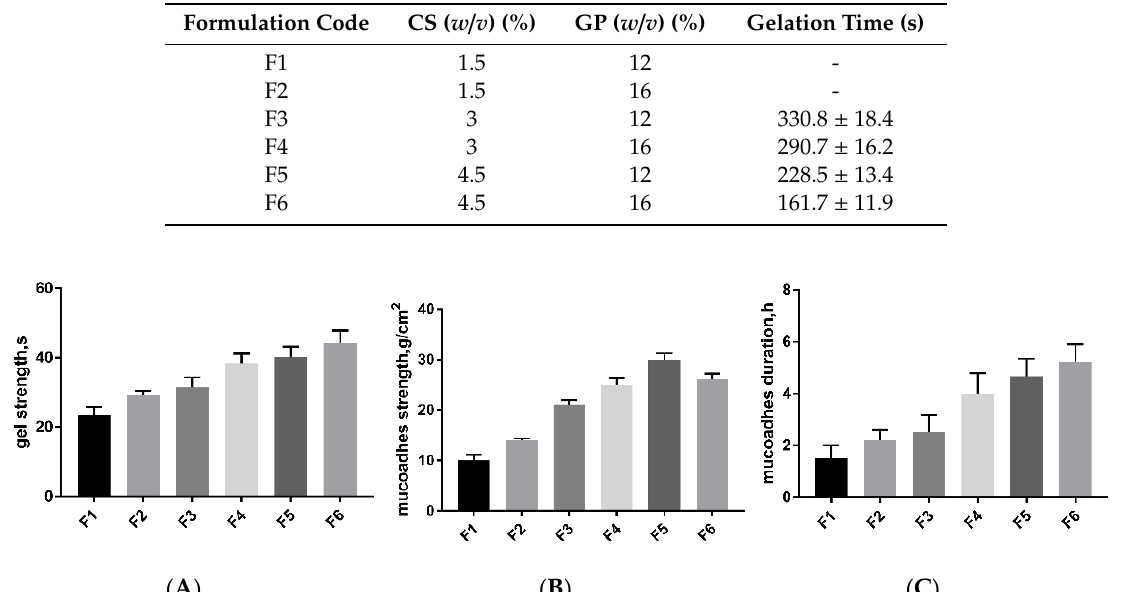
Figure 2. Gel properties. ( A ) Gelation gel strength, ( B ) mucosal adhesion strength and ( C ) mucosal adhesion duration of various thermosensitive mucoadhesive gel preparations (for gel composition, please refer to Table 2). The data represent the mean ± SD ( n = 4). Table 3. Evaluation parameters for miR-146a in chitosan